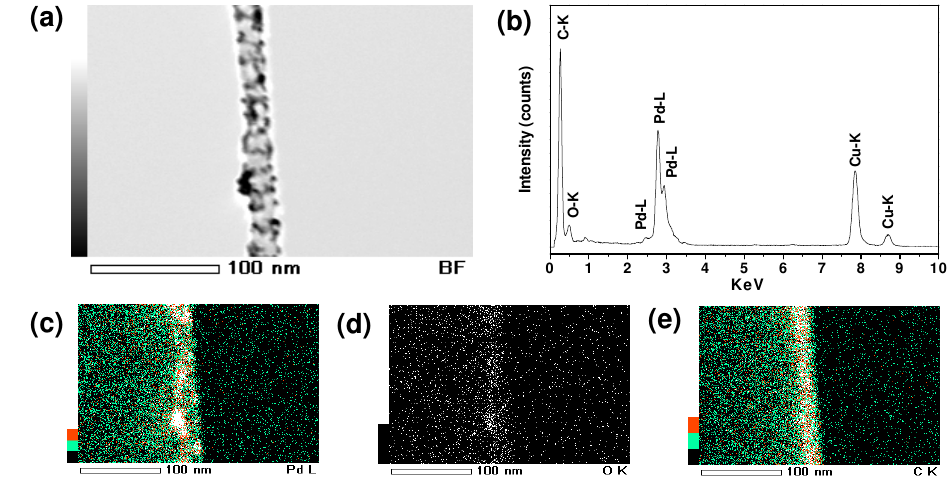
Figure 7. EDS and element mapping of MWCNT- g -PAA/PdO: (a) bright field, (b) EDS spectrum, (c-e) palladium, oxygen, and carbon maps.